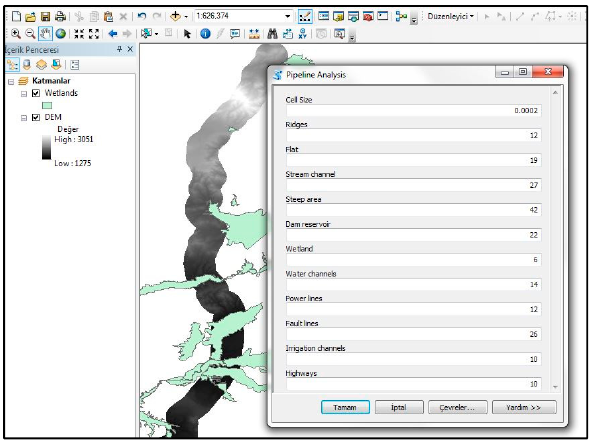
Figure 11. An interface for analysis with script code.